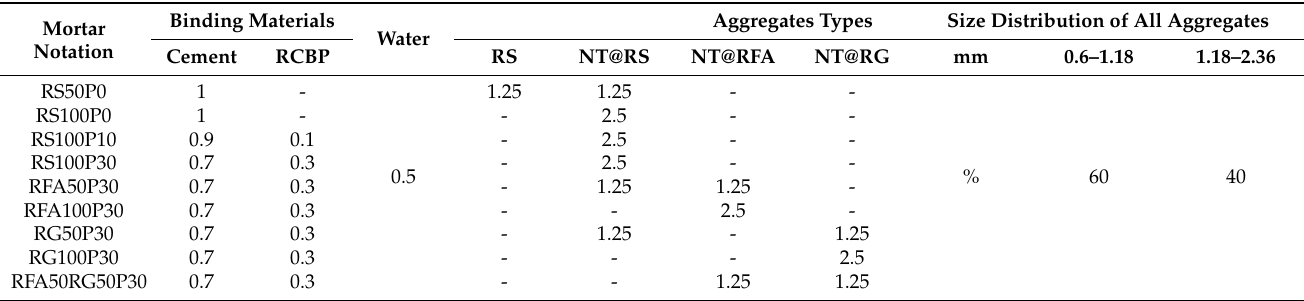
Table 7. Mix. proportion of photocatalytic mortars (for photocatalytic property).